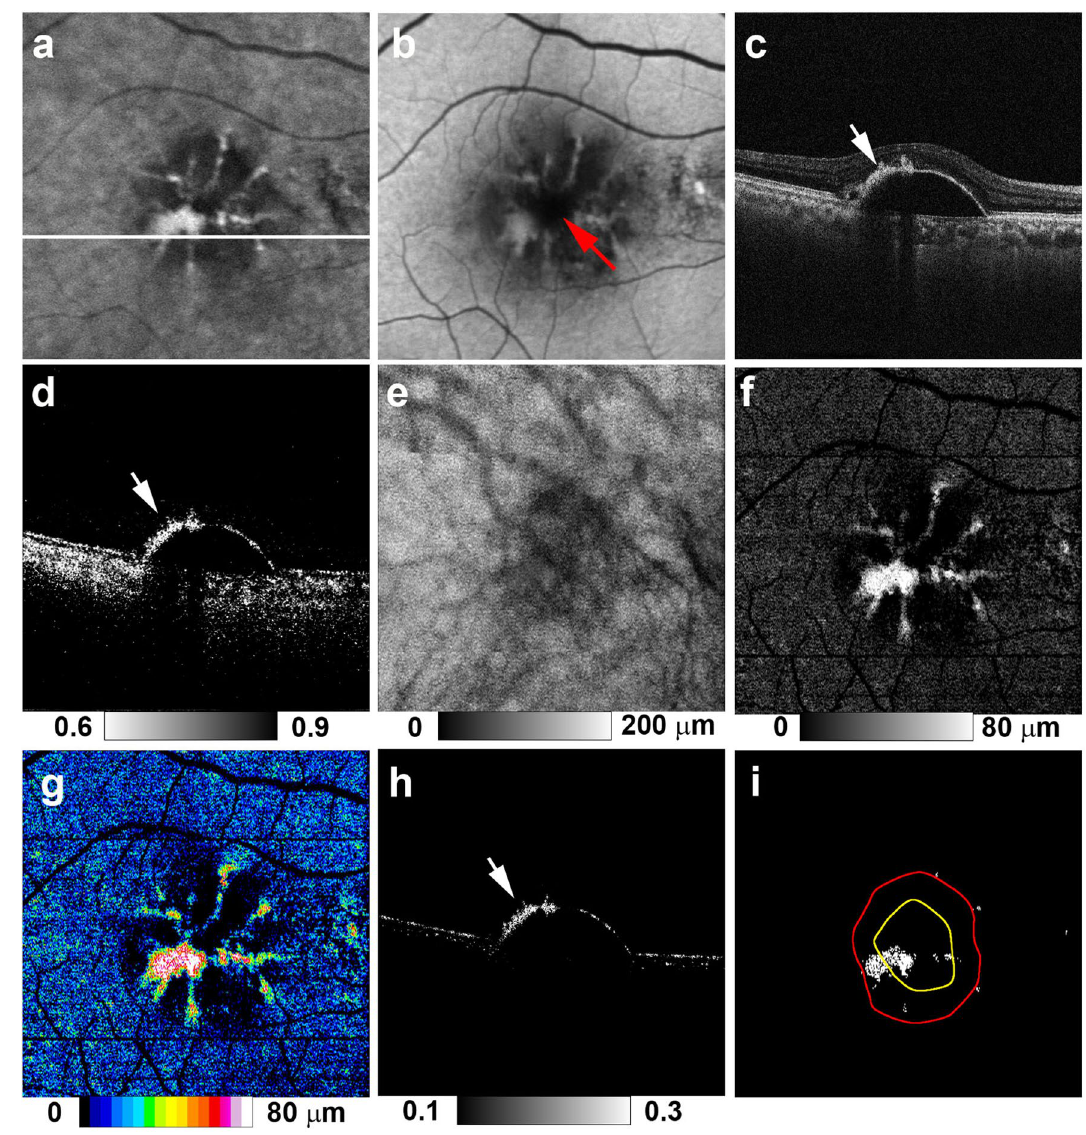
Figure 1. Multimodal imaging of serous PED in the right eye of a 78-year-old man. NIR-AF ( a ) and SW-AF ( b ) images show hyper-AF lesions. In the SW-AF image ( b ), the hyper-AF lesion is obscured in the foveal region (red arrow). The white line in the NIR-AF image ( a ) designates the scanning line of the MC-OCT B-scan images ( c , d , h ). The standard OCT B-scan image ( c ) shows a thickened RPE band and intraretinal hyper-reflective foci in the hyper-AF lesion. The DOPU B-scan image ( d ) shows melanin accumulation at the RPE band and intraretinal melanin foci (arrow). RPE changes in the hyper-AF lesion are not evident in the chorioretinal melanin thickness map ( e ). The greyscale RPE-melanin thickness map ( f ) is similar to the AF images ( a , b ) and RPE-melanin thickness is readily visible on the color-coded RPE-melanin thickness map ( g ). The RPE-melanin B-scan image ( h ) shows RPE-melanin accumulation at the RPE band and intraretinal RPE-melanin foci (arrow). En face distribution of RPE 70 is shown in panel ( i ). The red line indicates the margin of the PED and the yellow line indicates the axis position for 70% of the maximum PED height. RPE 70 areas in this patient were distributed in both the peak and slope calculated. First, simple linear regression analysis was performed between RPE 70 area ratios and morphometric PED parameters (Table 4, Fig. 3, and Supplementary Fig. S3 online). The RPE 70 area ratio in the slope region showed a significant negative correlation with the slope area ratio (Table 4, Fig. 3). Stepwise multiple linear regression analysis confirmed this significant negative correlation (Table 5).